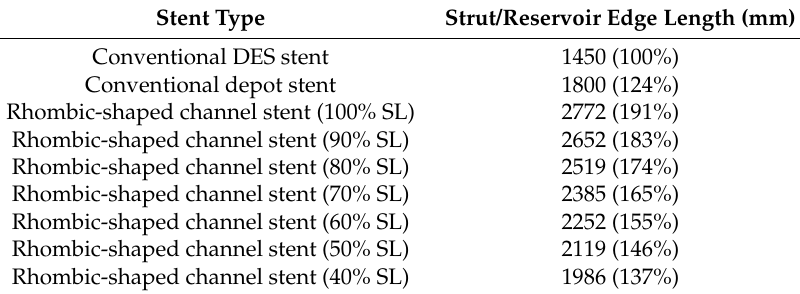
Table 3. Comparison of strut/reservoir edge